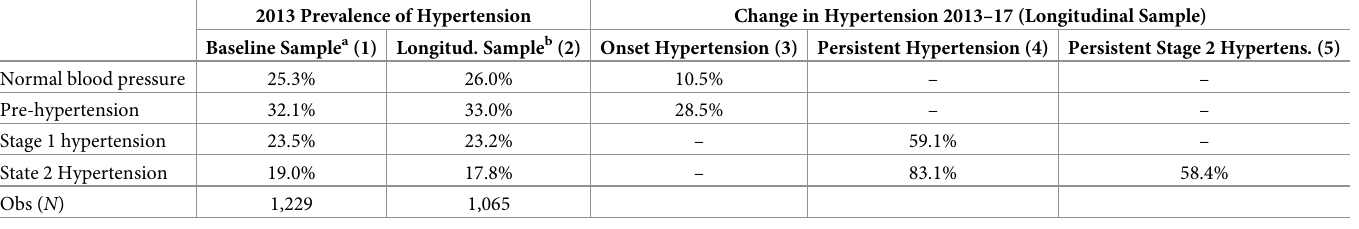
Table 1. Prevalence of hypertension in 2013, and onset and persistence of hypertension during 2013–17 among MLSFH mature adults. 2013 Prevalence of Hypertension Change in Hypertension 2013–17 (Longitudinal